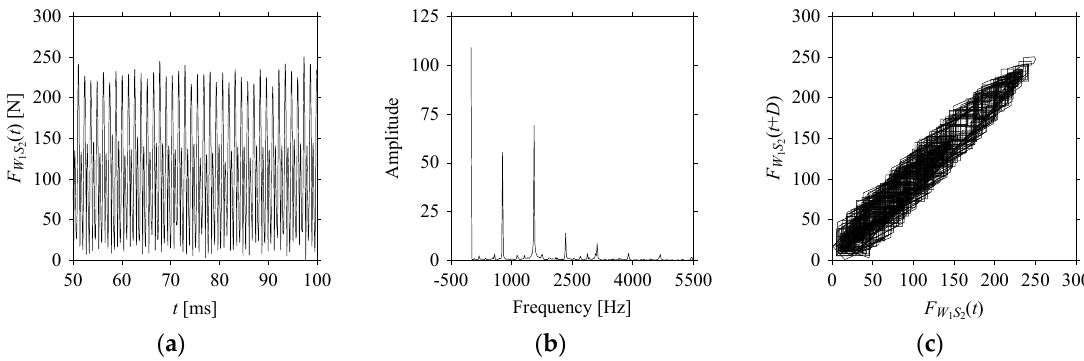
Figure 10. F W in the form of: ( a ) time series, ( b ) fast Fourier Transformation (FFT), and ( c ) delay map ( d = 1). 1 S 2